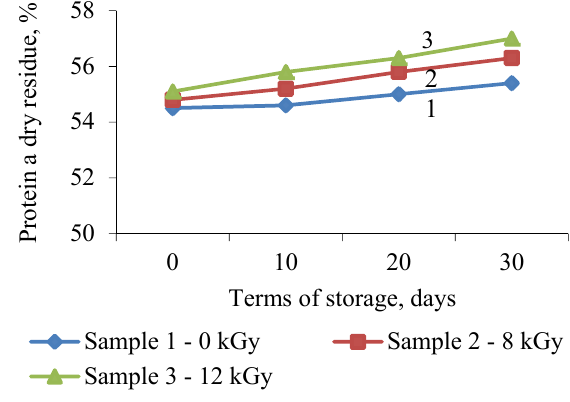
Fig. 10. Dynamics of protein in the dry residue in the control and experimental samples of the refrigerated pork neck on the bone packed using MAP during